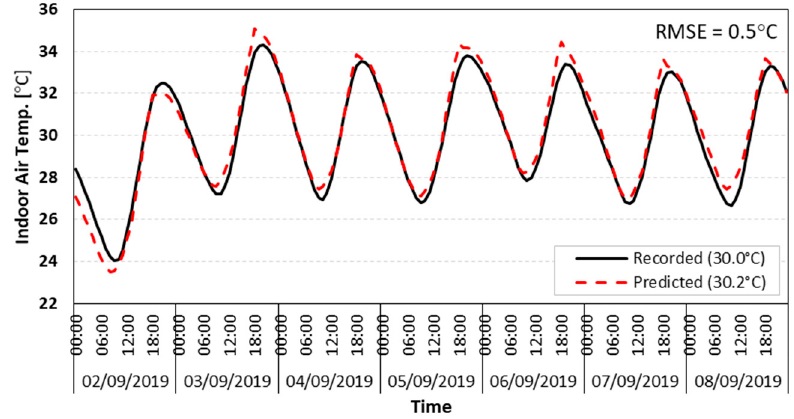
Figure 8. Predicted and measured indoor temperatures in module 2 (with a Trombe wall).